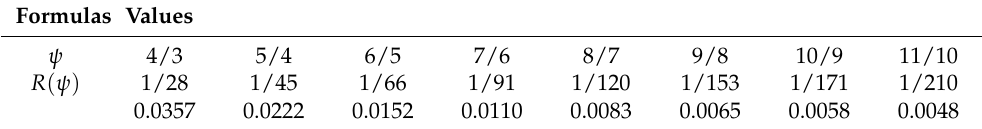
Figure 10. Free oscillation for the first mode of oscillation leading to k = k 1 = π / L , with damp- ing δ = 0.5 c / L , no phase shift, α = 0, and at the middle of the string, x = L /2 (dashed line); forced oscillation, also for the first mode of oscillation, k = k 1 = π / L , with opposing amplitude to the free oscillation, F = − EA / c 2 , with applied phase shift, β = − φ − α , and with damping ε = 4 δ /3 ≈ 0.667 c / L , representing the case VI (dotted line); total oscillation as the sum of free and forced oscillations, in these conditions given by (133) (solid line). The three oscillations are represented as functions of dimensionless time tc / L . Table 3. As the forcing decay comes closer to the damping, the reduction of total relative to free oscillation energy is more significant at the risk of coming too close to resonance, which could invalidate the